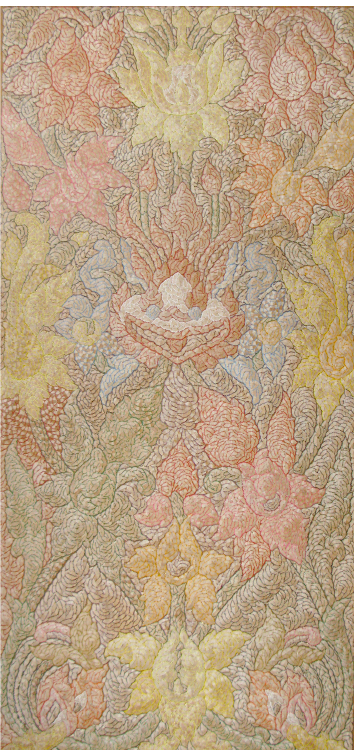
Chan Dany, Kbach Phni Vois (Wooden Door),